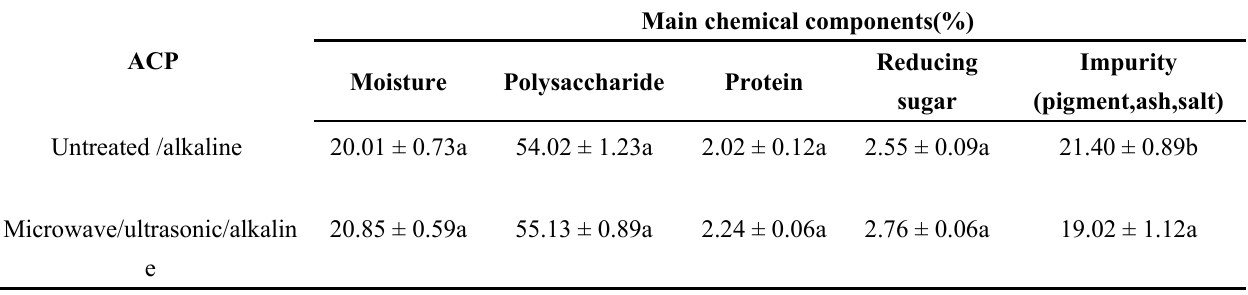
Table 3. Analysis of main chemical components of Ganoderma lucidum crude